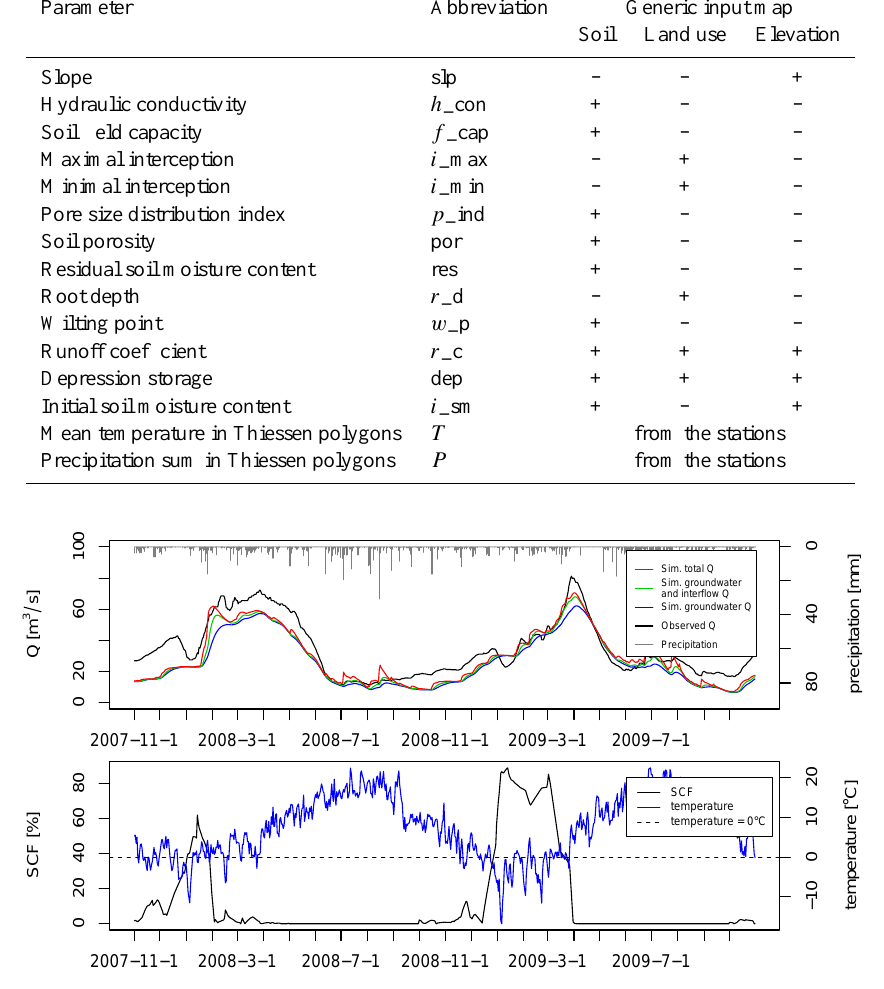
Table 2. WetSpa parameter maps used to analyze the sensitivity analysis results: the generic input maps used to derive the parameters maps are marked with + when used and – when not used.